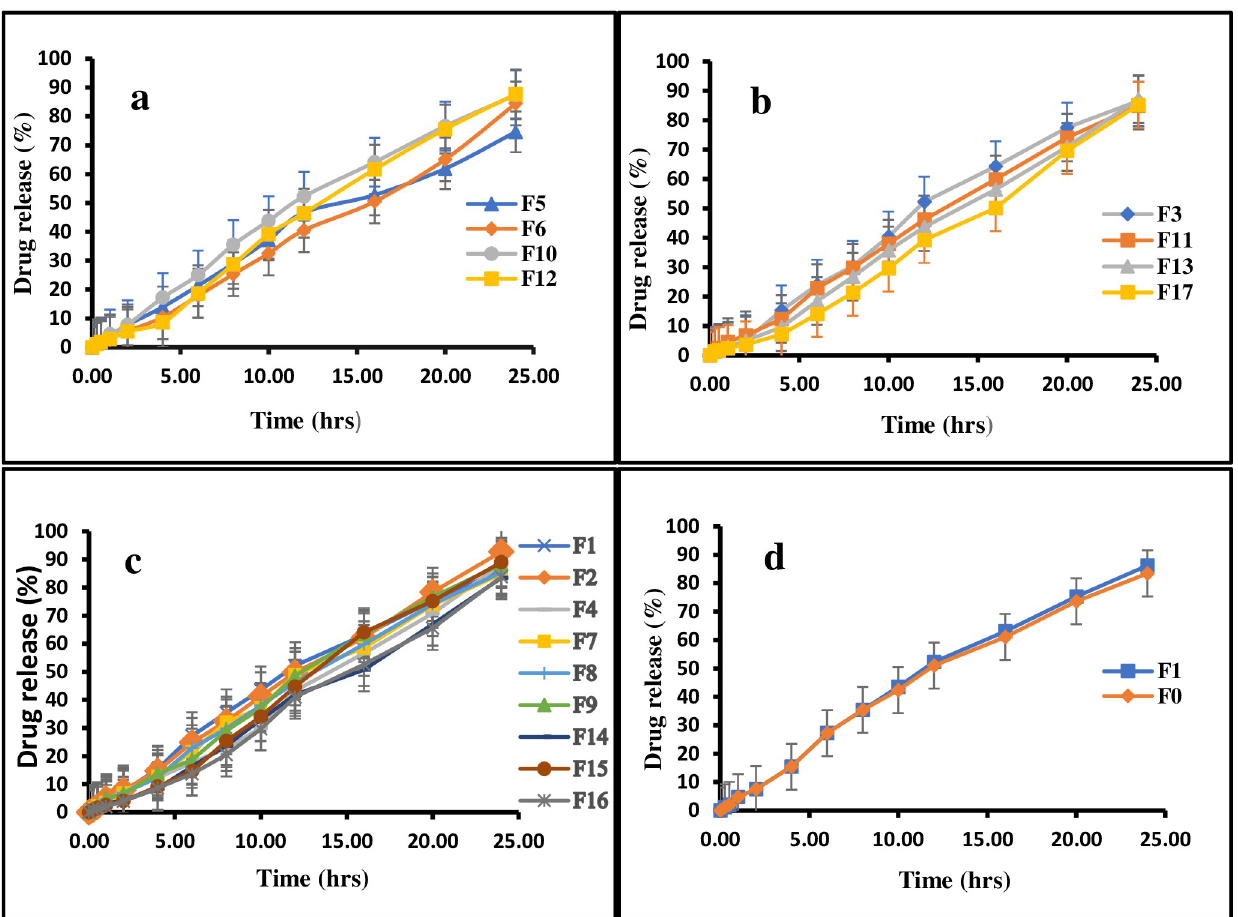
Fig 4. Drug release profile of microparticles fabricated with HPMC = 200 mg (a), 800 mg (b), and 500 mg (c), and design proposed optimized formulation (F1) and developed optimized formulation (F0), (d).